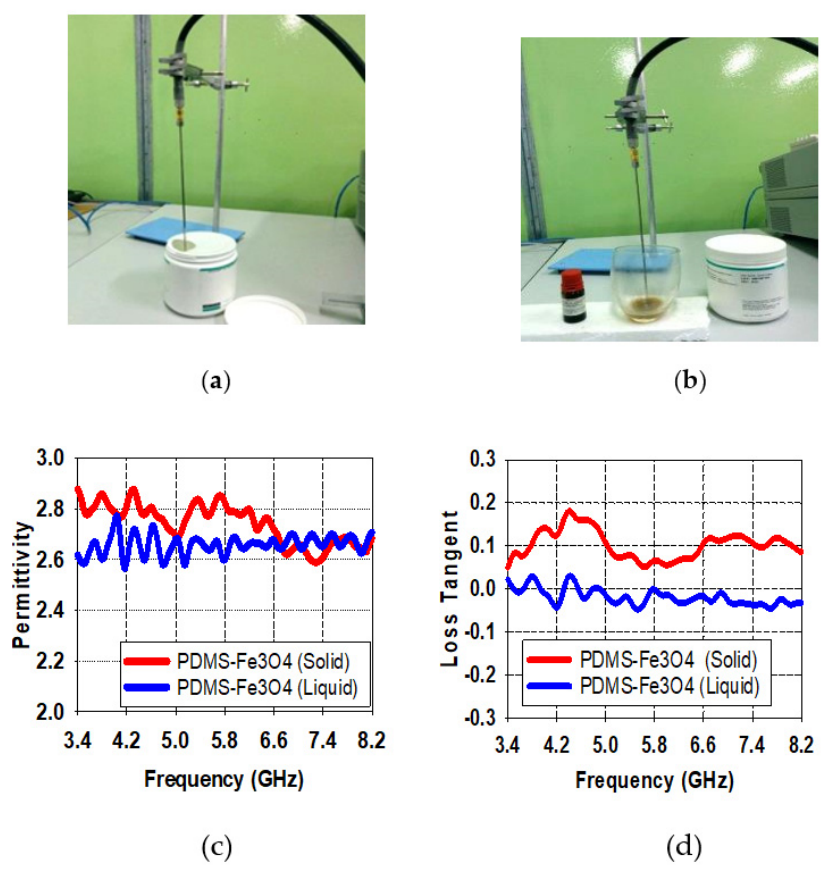
Figure 5. PDMS-Ferrite measurement results for dielectric characteristic; ( a ) liquid state and ( b ) solid state, result of measured permittivity PDMS in liquid and solid cases ( c ), and result of measured loss tangent PDMS in liquid and solid cases ( d ).